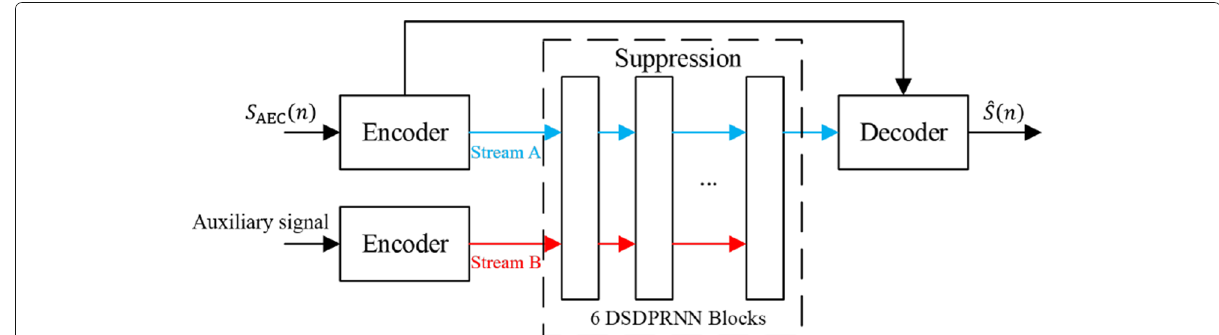
Fig. 2 The structure of our proposed DPRNN-based RES method. The blue line and the red line represent stream A and stream B respectively